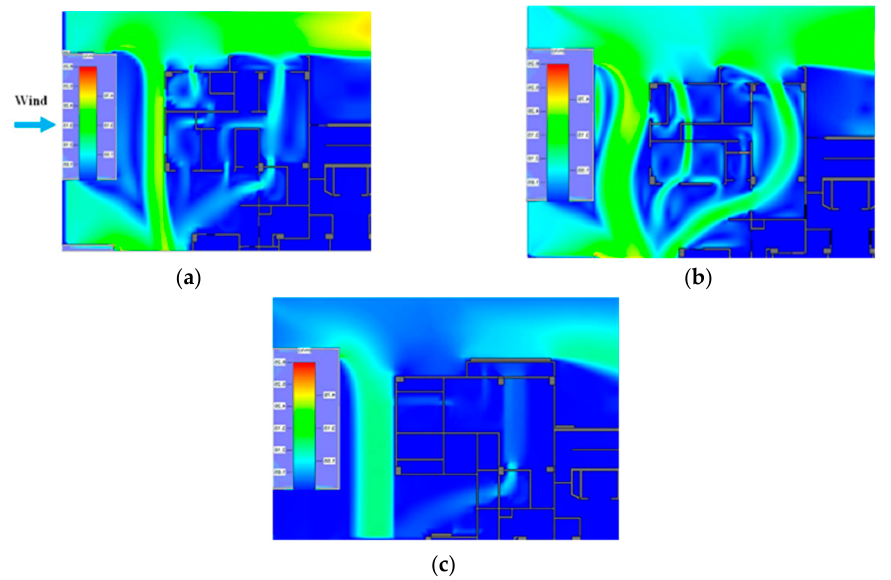
Figure 4. CFD simulation of indoor wind field in the life cycle of the design proposal targeting 100 years. ( a ) After the first adjustment; ( b ) after the second adjustment; ( c ) after the third adjustment.